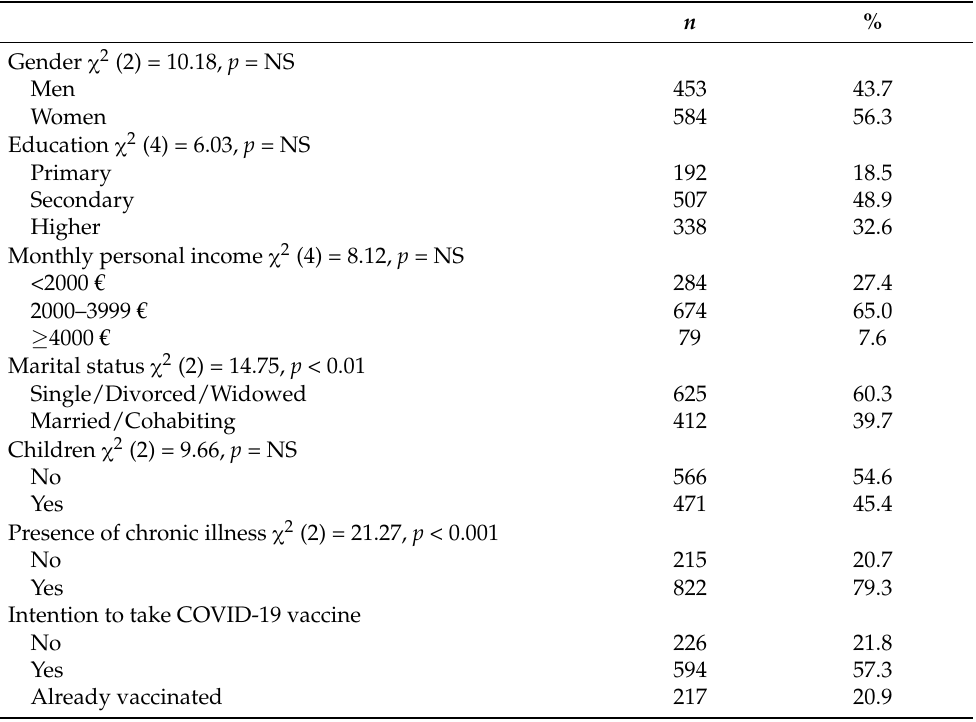
Table 1. Descriptive statistics for the study variables and Chi 2 -value for intention to get vaccinated if offered (three